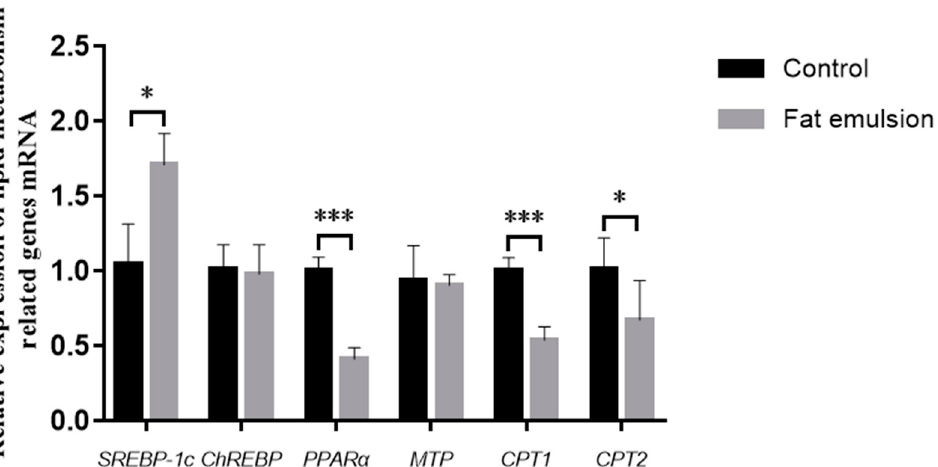
Figure 5. Effect of fat emulsion on the expression of lipid metabolism-related genes as determined by quantitative real-time PCR. Note: Data are presented as mean ± SEM. * p < 0.05, *** p < 0.001; statistical differences were assessed by one-way ANOVA with subsequent Tukey’s HSD test.